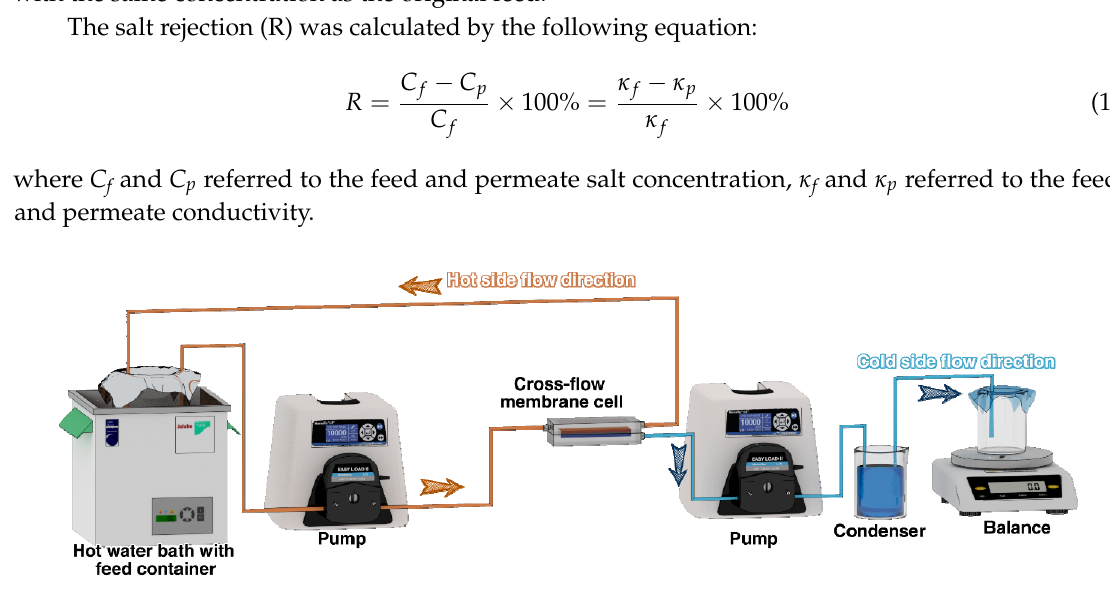
Figure 1. Schematic diagram of cross ‐ flow pervaporation setup with flat ‐ sheet membrane module.